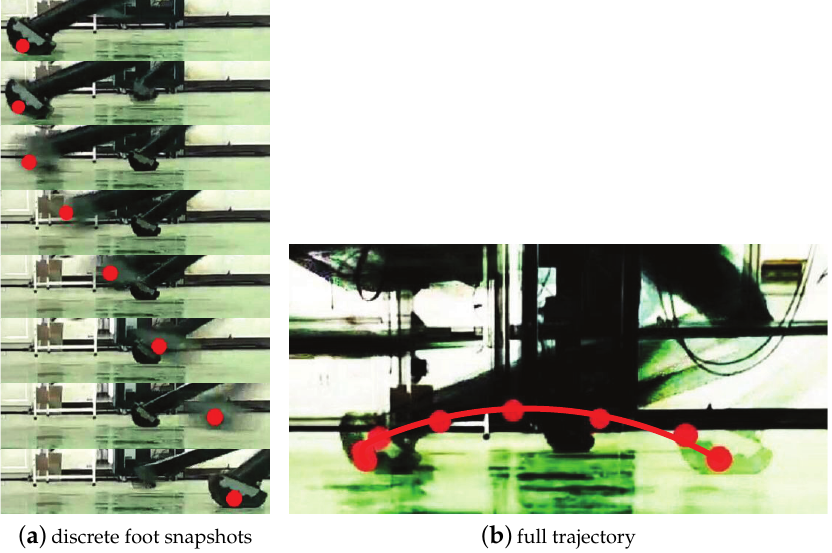
Figure 18. Foot trajectories in physical experiments.